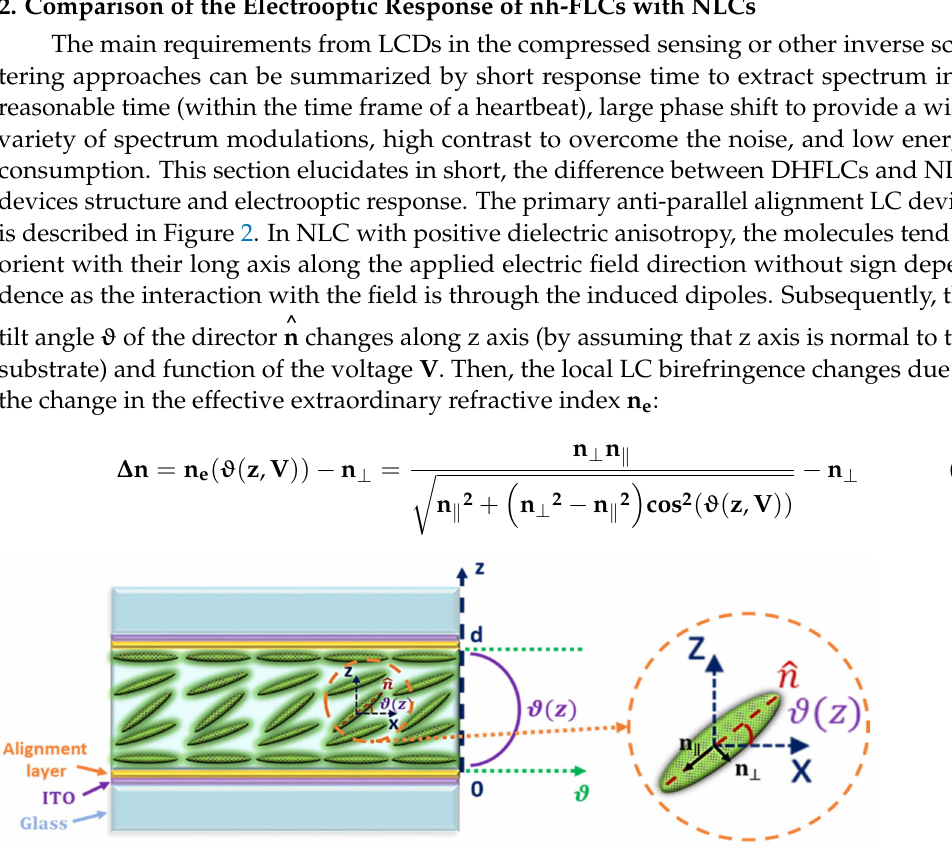
Figure 2. Schematic structure of anti-parallel aligned NLC device. The left side presents the NLC device structure, the right part shows a zoom for the molecular orientation according to the axes (assuming that the alignment direction is along the x axis) and ϑ ( z ) represents the director